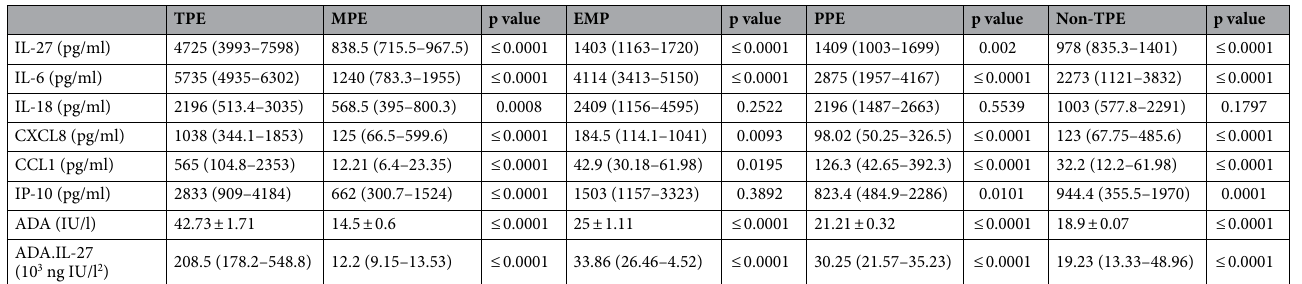
Table 3. The concentrations of the ADA, cytokines and chemokines in pleural effusions*. All values except those for ADA and ADA.IL-27 are presented as the median and 25–75% percentile and comparisons made between TPE and the other groups were performed using the Mann–Whitney U test. Values for ADA and ADA.IL-27 are shown as mean ± SEM. Comparisons of data between TPE and non-TPE groups were performed using the Student’s t test. IL interleukin, CXCL C-X-C motif chemokine ligand, CCL C–C motif chemokine ligand, IP-10 interferon gamma-induced protein 10 or CXCL10, ADA adenosine